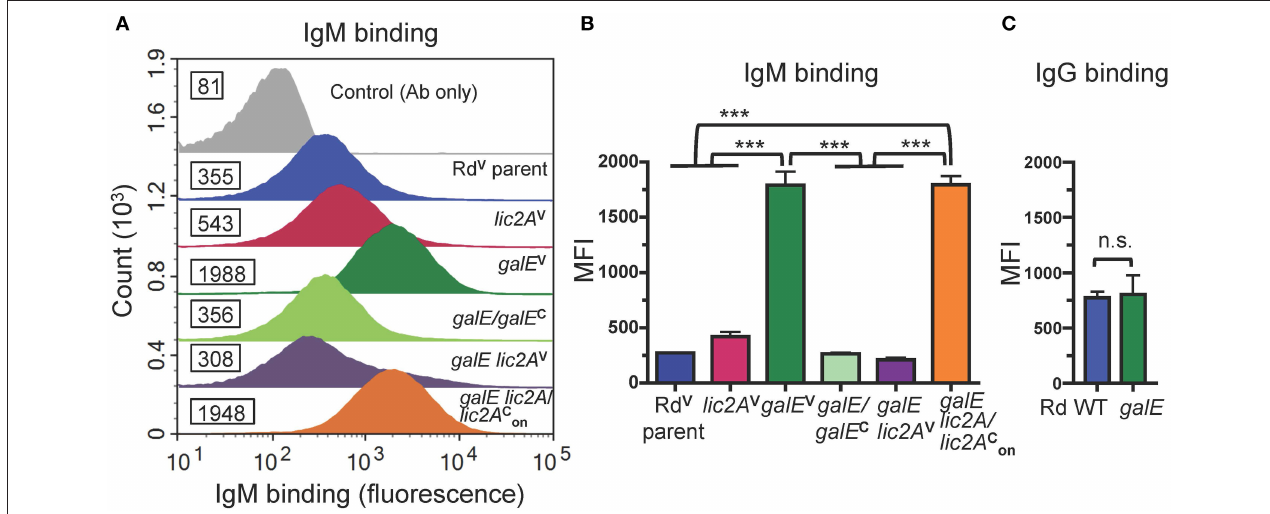
FIGURE 7 | Increased binding of IgM but not IgG to the galE mutant and galE lic2A containing lic2A phase-on locked. (A) Rd strains grown in MIc SA were incubated with NHS 1 i at 20% final concentration at 37 ◦ C for 30min followed by detection via flow cytometry with anti-human IgM conjugated to FITC. X-axis, fluorescence; Y-axis, counts. Numbers alongside histograms indicate the median fluorescence intensity (MFI) of the bacterial population. Control antibody (Ab) only fluorescence values are similar for all strains and one representative is shown (Rd V parent). One representative experiment of two reproducible repeats is shown. (B) IgM and (C) IgG binding for the mean of replicate samples of which one is shown in (A) for IgM. Statistical significance was evaluated by one-way ANOVA with Bonferroni’s multiple comparison test (*** p < 0.001; n.s., not statistically